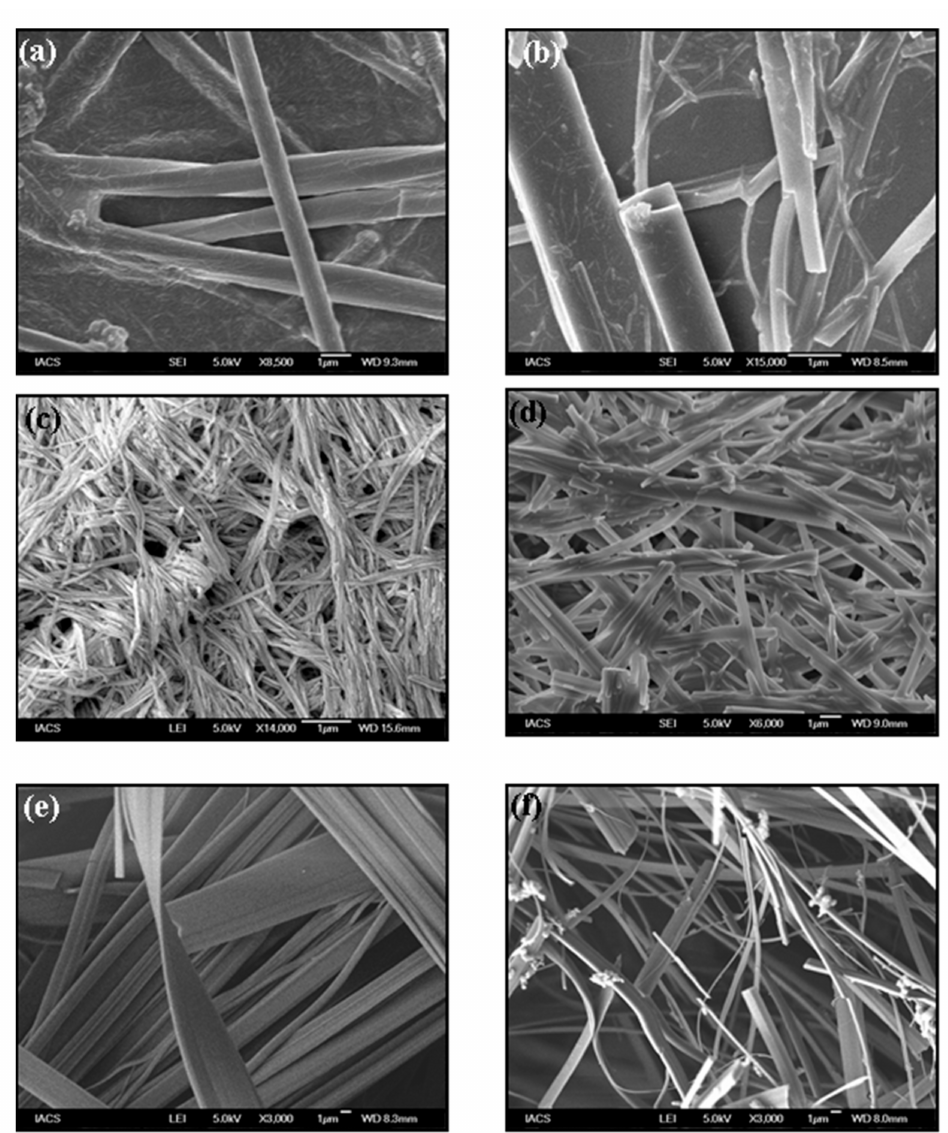
Figure 3. FESEM images of ( a , b ) MEM:TPCA 1:1, ( c ) MM:TPCA 1:1, ( d ) MM:BTA 1:1, ( e )